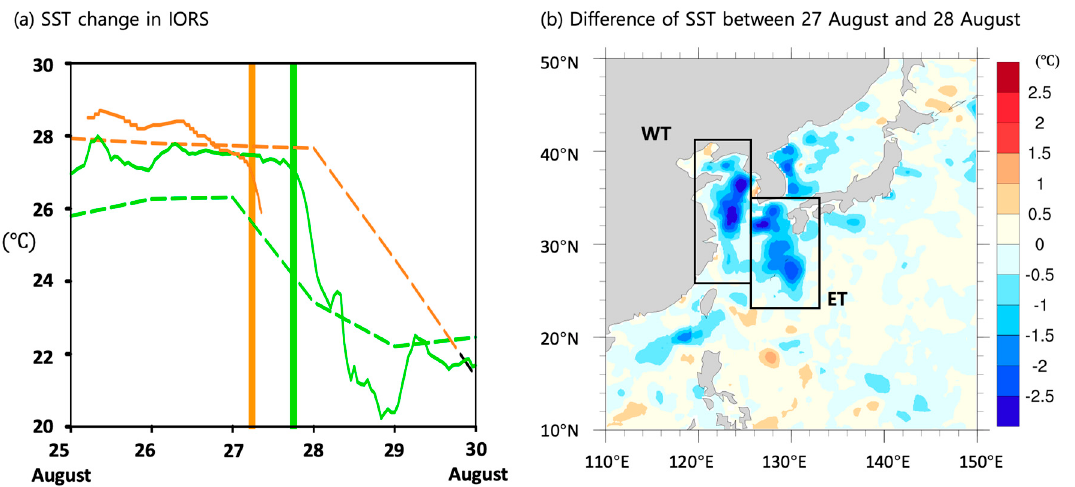
Figure 2. ( a ) Time evolution of the Sea Surface Temperature (SST, unit: ◦ C) of observed station and OISST.v2, and green solid (dashed) line indicates the SST located at YS buoy (OISST.v2 at YS buoy point), and orange solid (dashed) line indicates the SST located at the IORS (OISST.v2 at the IORS point). The orange (green) vertical line means when Typhoon Bolaven passes through the IORS (YS buoy). ( b ) Spatial distribution of the di ff erence in SST between 27 August and 28 August. The left box is the defined western region of Tembin (WT); the right box is the defined eastern region of Tembin (ET).